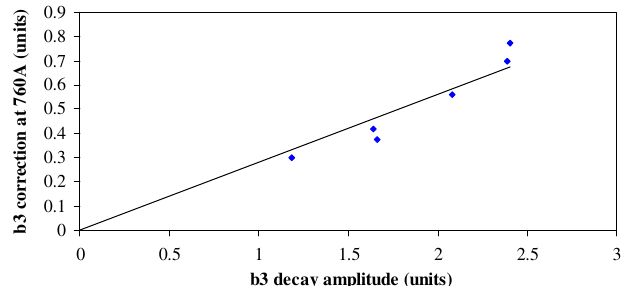
FIG. 10. (Color) The b 3 correction at 760 A vs the b 3 decay amplitude at 760 A.